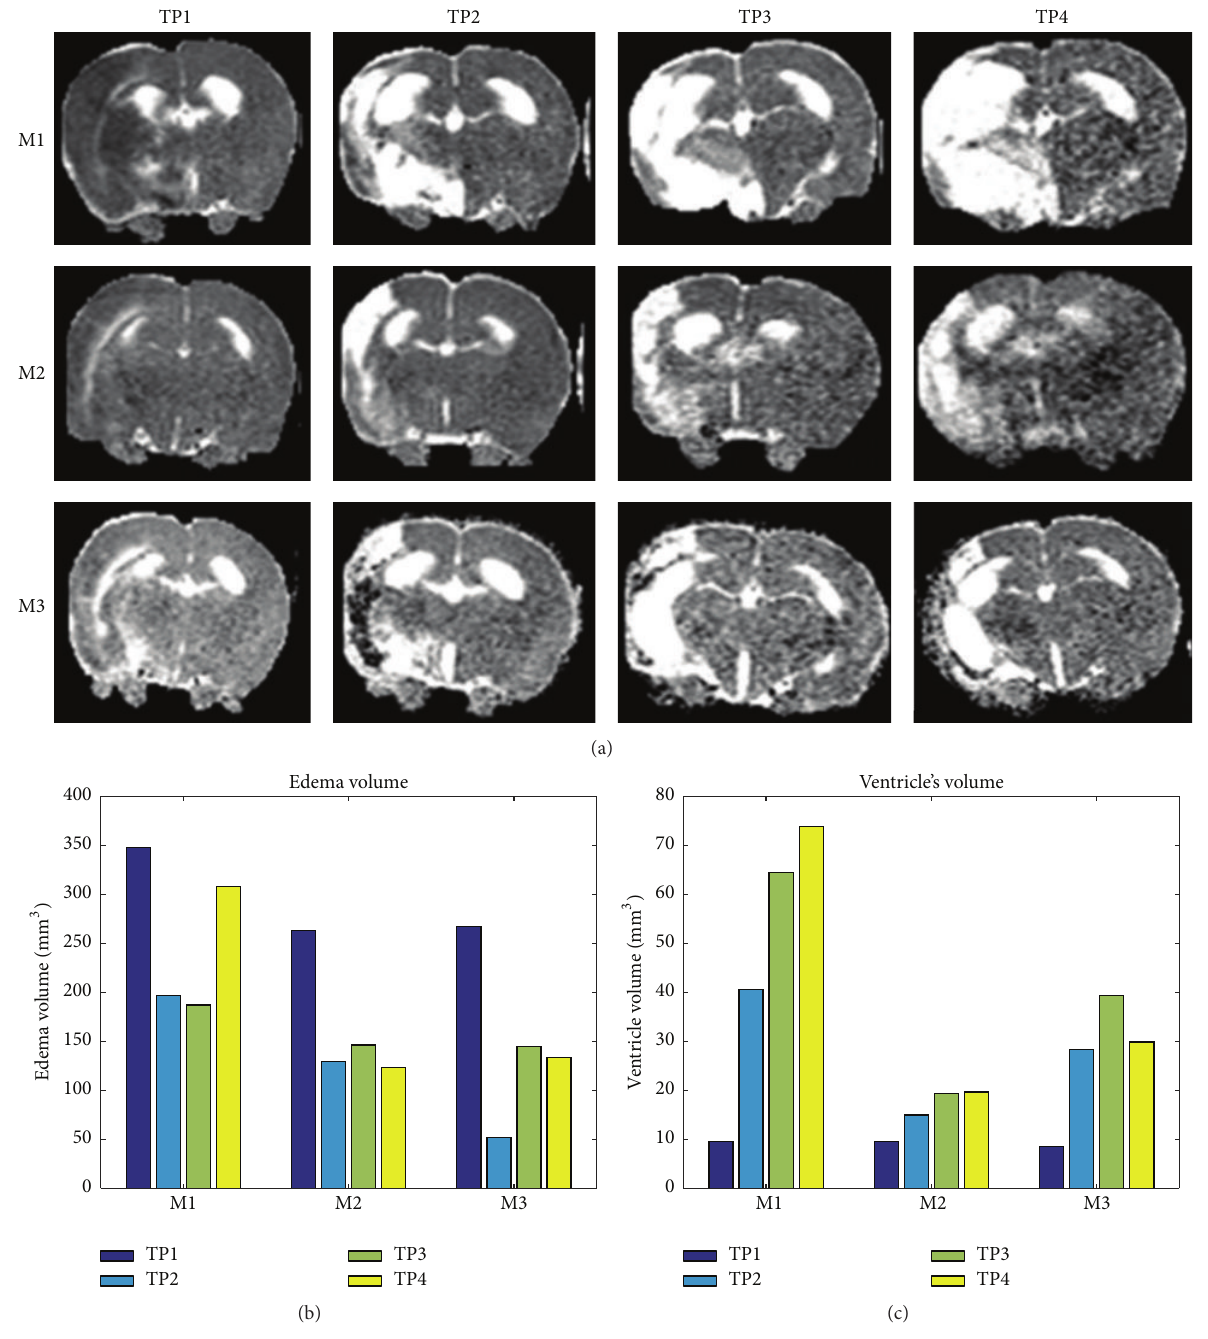
Figure 4: Edema and right ventricle’s volume (affected hemisphere). The edema region was measured in each time point in the T2 maps, the region of high intensity T2 was measured in all slices (a). Quantitative data of edema’s volume (b) and right ventricle’s volume (c) is shown in each rat at each time point in one representative MRI slice. One day after tMCAO (TP1), two weeks after the first treatment (TP2), 1 month after the first treatment (TP3), one month after the final treatment session (TP4). M1 is a group receiving sham treatment, M2 was exposed to 3.93 Hz, and M3 was exposed to 15.72 Hz VLIFE 2min sessions, in alternate days, for a month and followed up for an additional